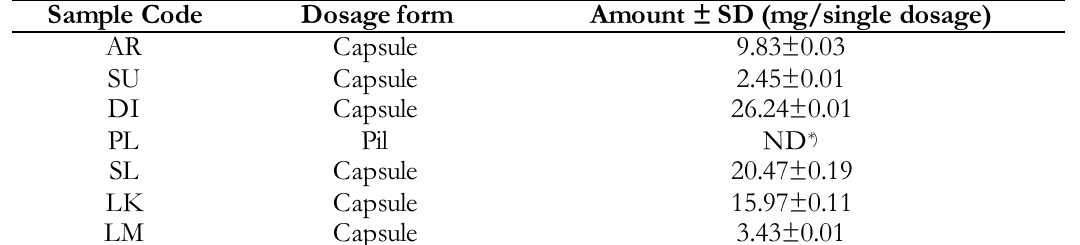
Tabel III. The content of sibutramine HCl in herbal slimming products Sample